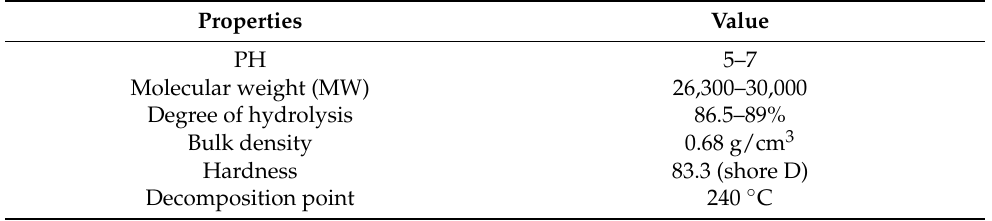
Table 3. Properties of Polyvinyl alcohol.